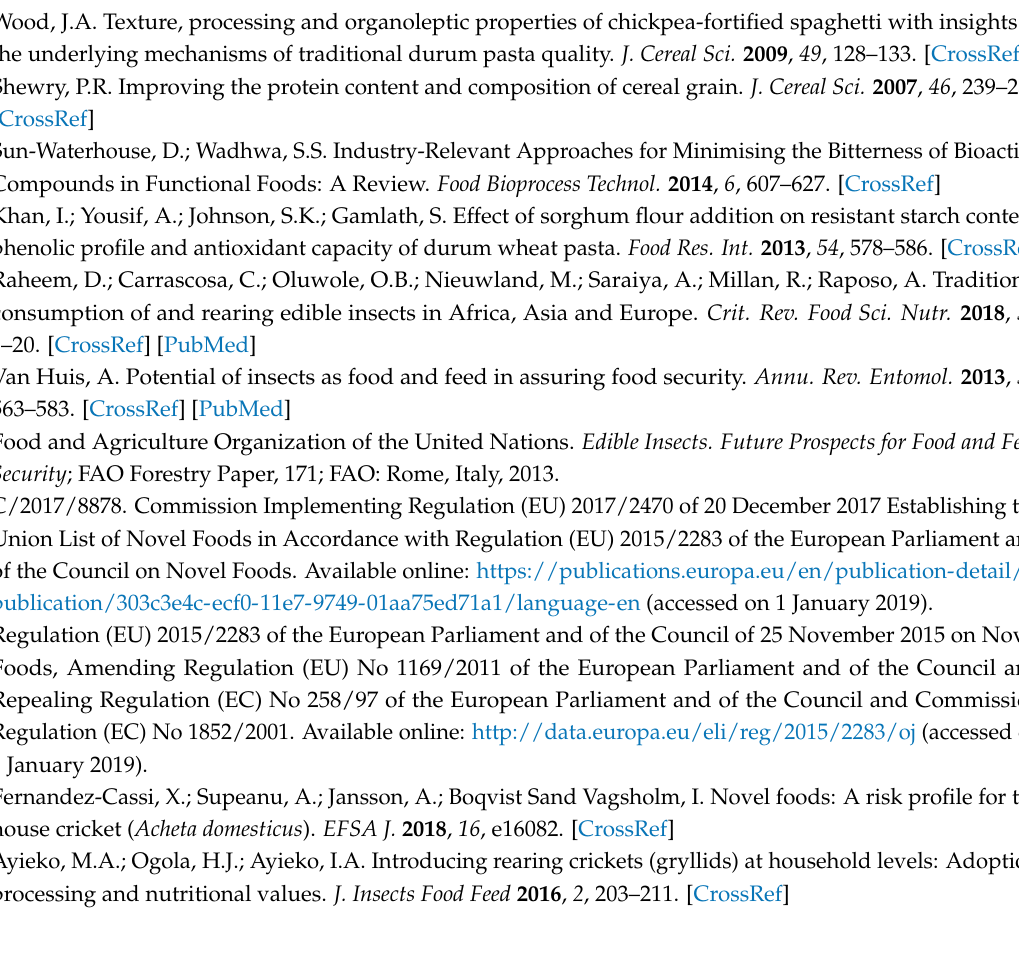
Table S1: Correlations matrix for investigated variables ( p <